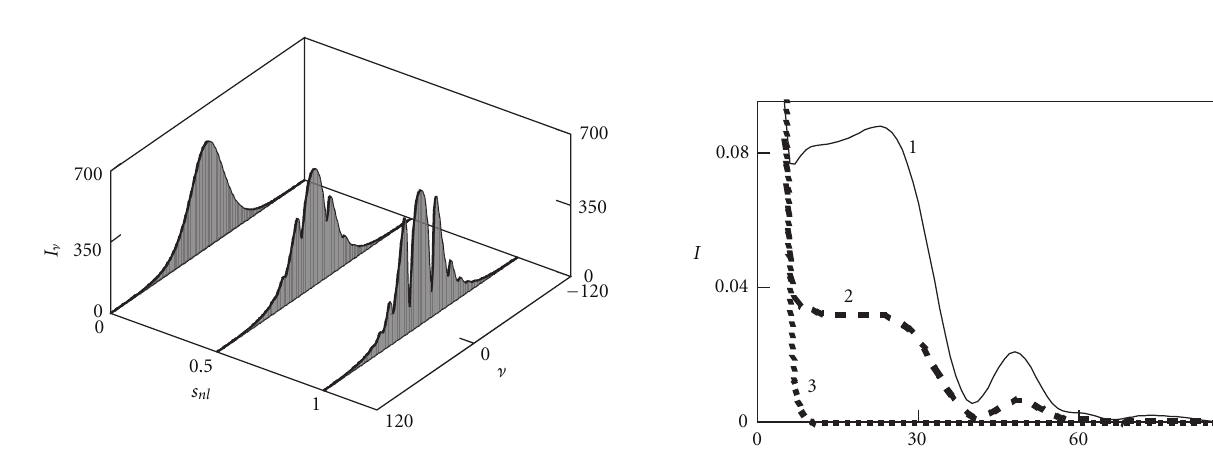
Figure 16: Change in spectrum of single ultrashort pulse with the change in a value of lumped part of saturable absorber s nl . The total value of nonlinear losses remains the same.